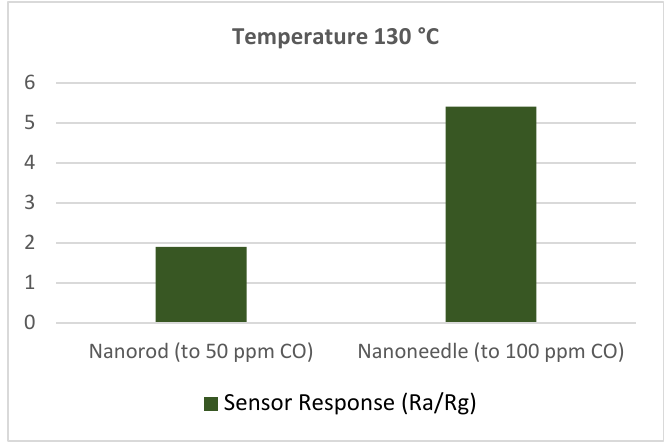
Figure 20. Response comparison between Co 3 O 4 nanorod and nanoneedle.